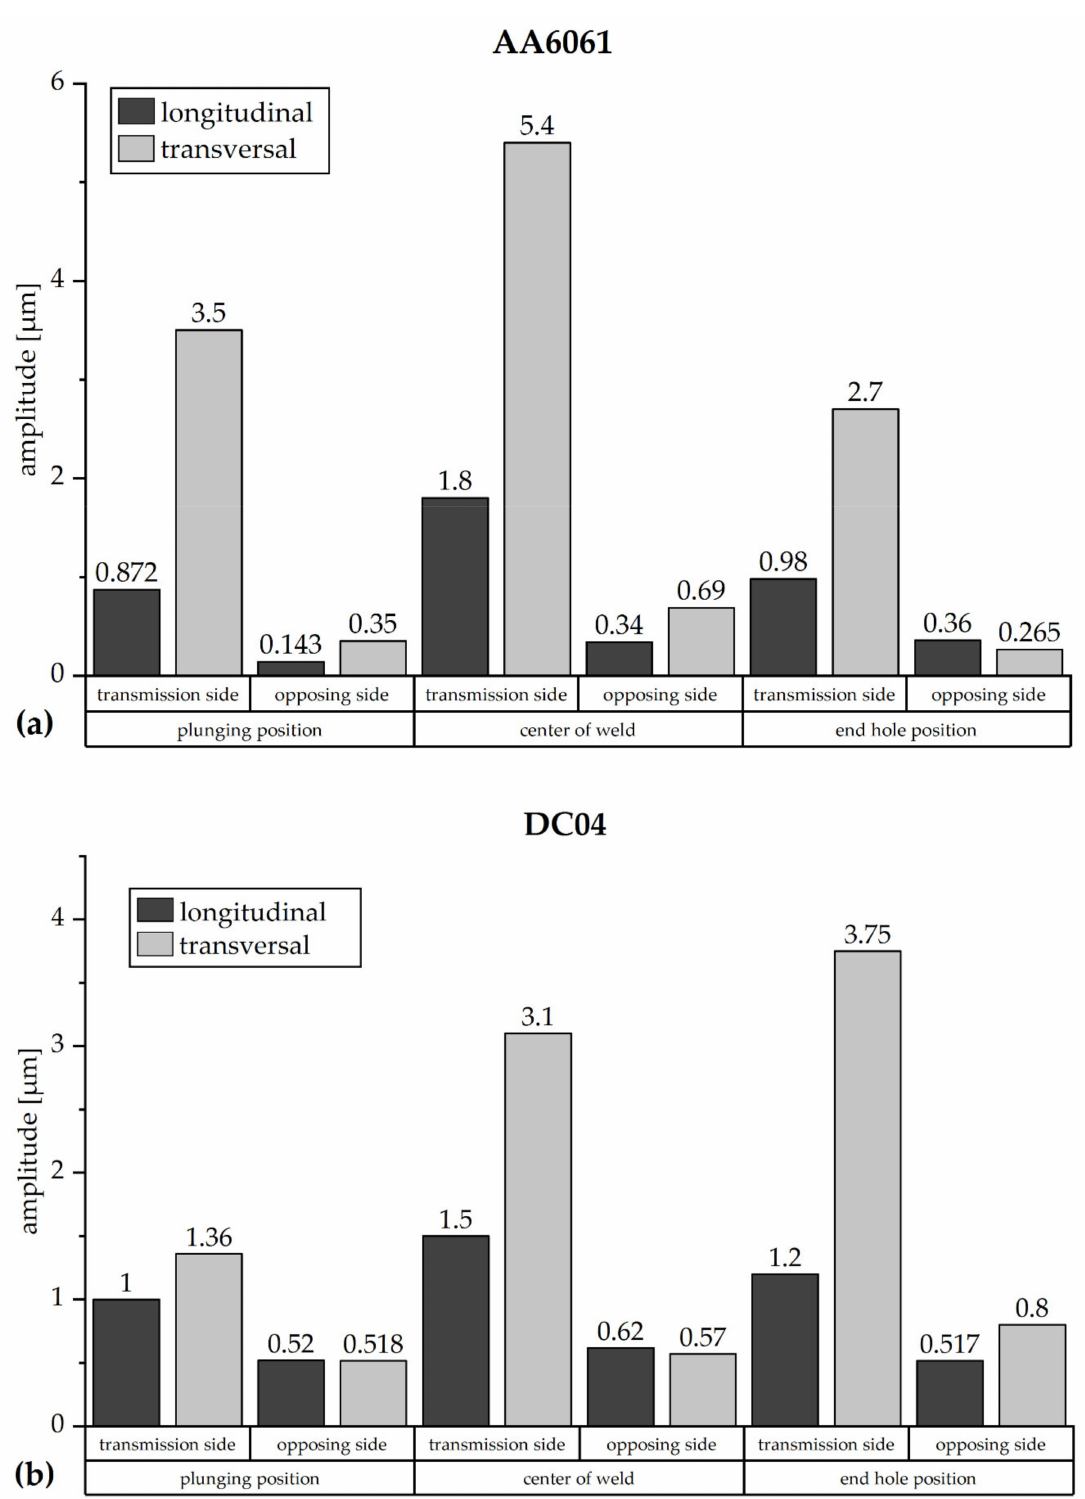
Figure 4. Proportions of longitudinal and transversal oscillations depending on the transmission position of the horn in ( a ) AA6061 and ( b )